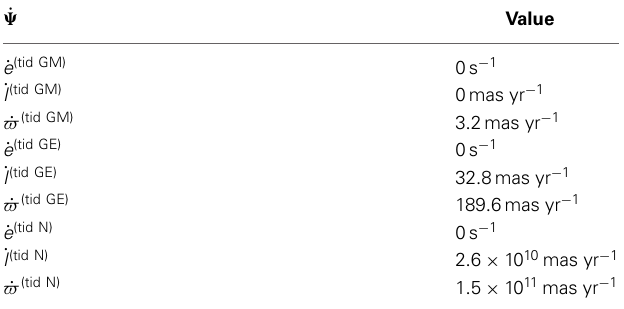
Table 3 | Maximum nominal values of the direct orbital rates of . = (cid:4) + ω is the longitude of the pericenter) of a change ˙ (cid:2) (here, (cid:3) member of a spaceborne artificial mini-planetary system orbiting a tungsten sphere of mass M = 28kg and radius R = 7cm in a circular orbit with a = 10cm, e = 0, I = 90 ◦ averaged over both P b and P (cid:2) b , induced by the post-Newtonian gravitoelectric and gravitomagnetic tidal field of the Earth and by its Newtonian tidal